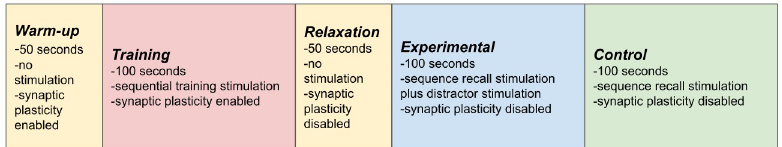
Fig 2. Experimental protocol. A symbolic diagram and description of the experimental